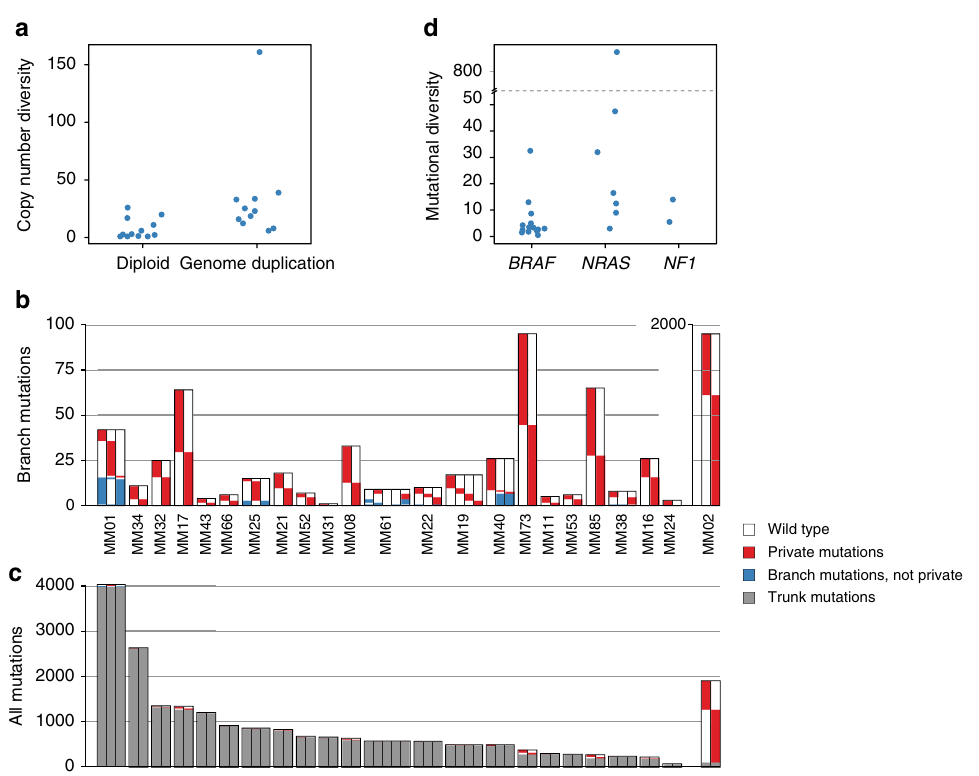
Fig. 2 Mutational heterogeneity. a Copy number diversity according to whether genome duplication was identi fi ed in samples from each patient. b Branch mutations (found in more than one, but not all samples) and private mutations (found exclusively in one sample) per lesion. For MM02, a separate axis is used to capture the large number of private mutations. c All mutations (private, branch, and trunk mutations) presented together for each lesion. d Mutational diversity (average number of branch mutations per sample) in patients according to driver mutation status of BRAF and NRAS . The Y - axis is broken for clarity due to the high mutational diversity in